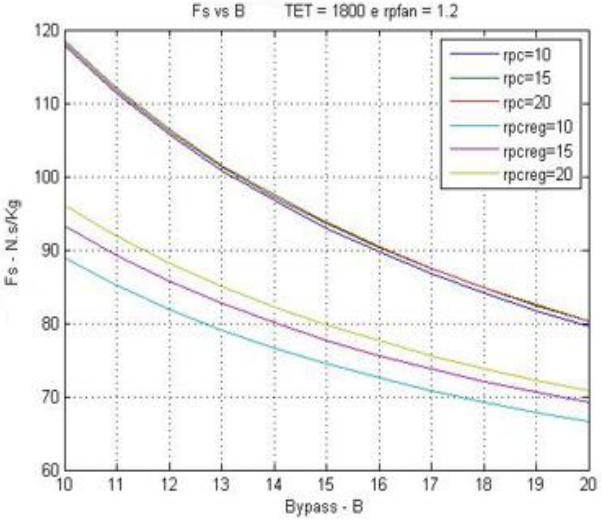
Figure 3: Fs vs BPR with and without regeneration (TET 1800 K and rpfan 1.2)